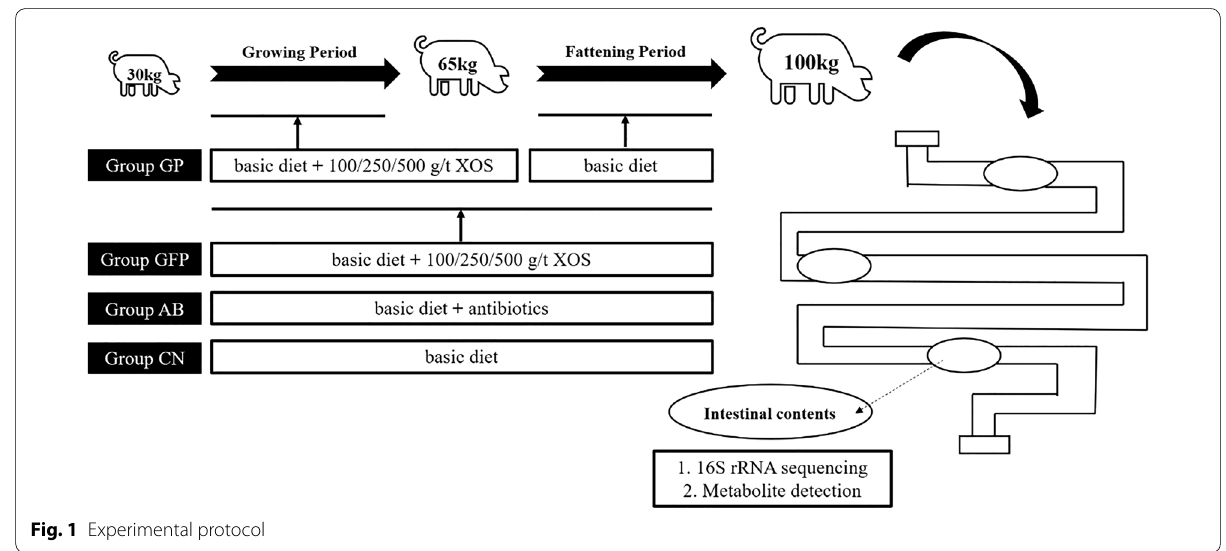
Fig. 1 Experimental protocol